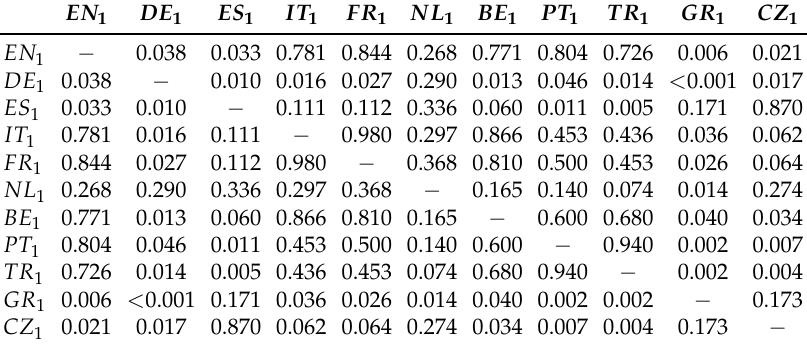
Table 5. p -values of the test for homogeneity of parallel samples for the highest leagues over all ten seasons.